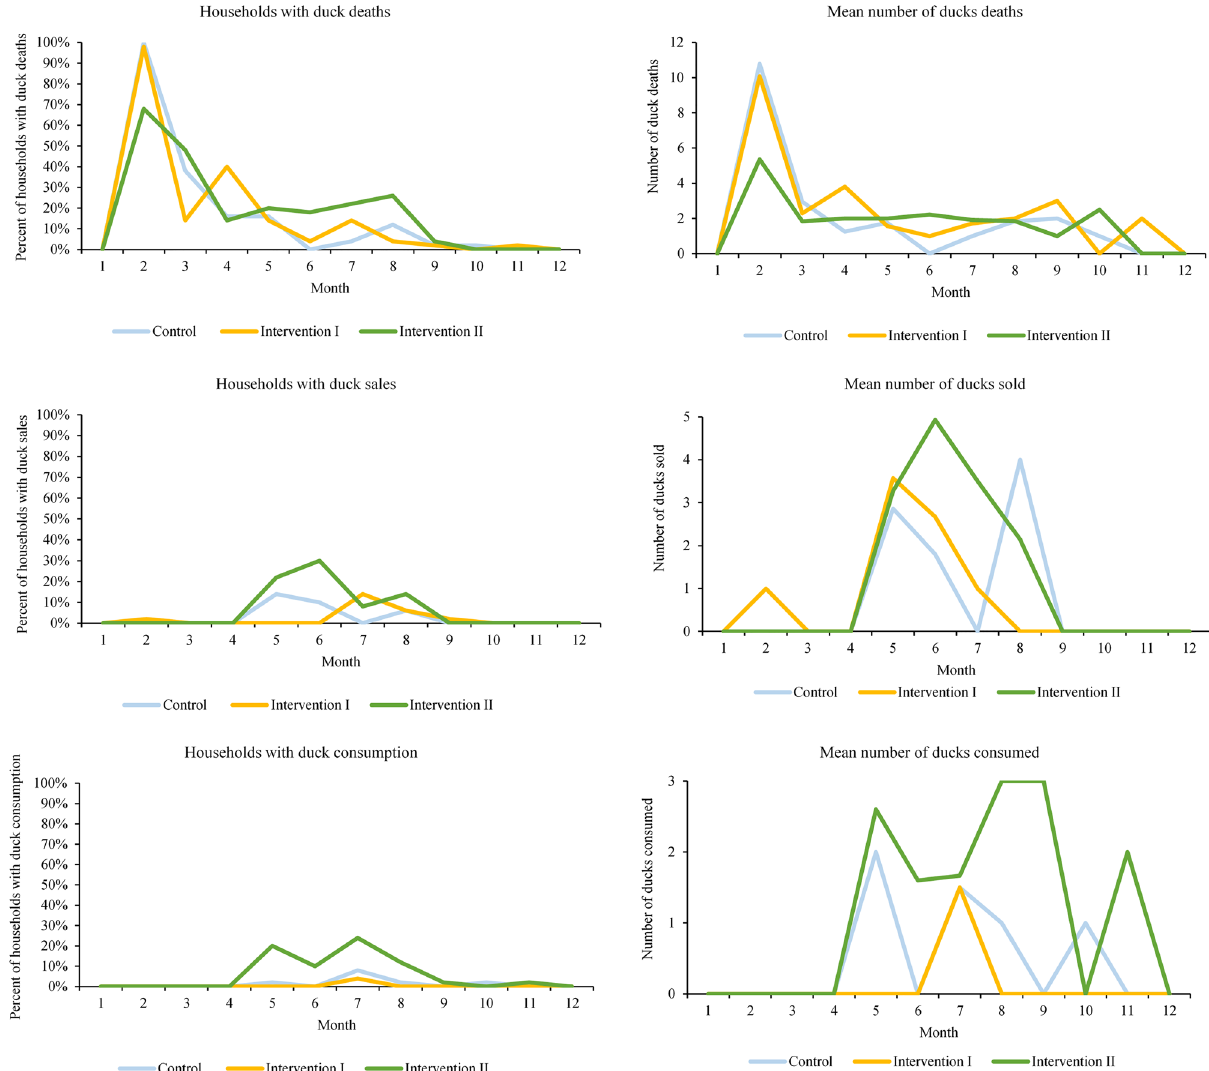
Treatment group per